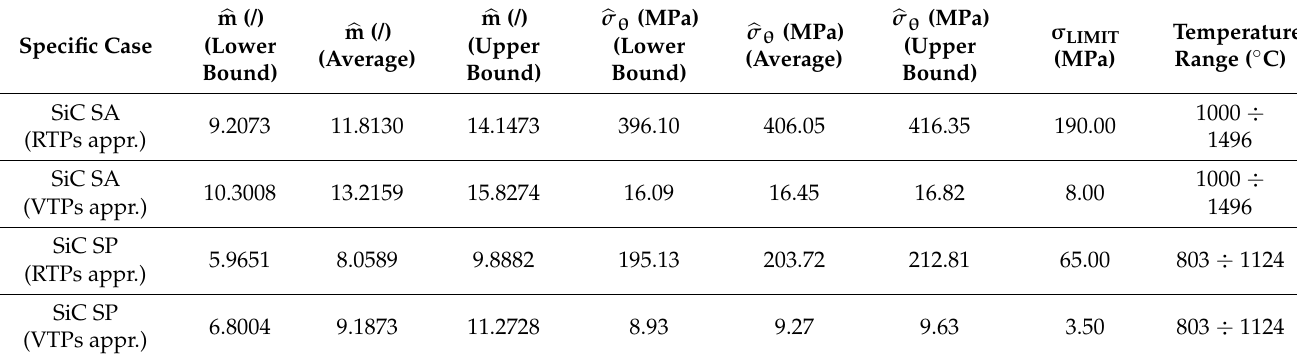
Table 6. Weibull distribution parameters (with 90% confidence bounds) and calculated stress limit values.